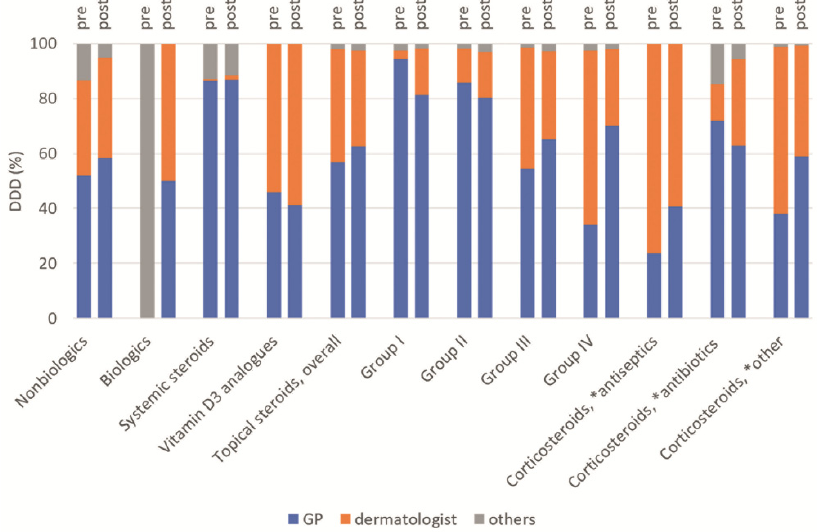
Figure 2. Proportion of defined daily dose (DDD) of the most prescribed psoriasis-relevant drugs by prescribing specialist group in pre–post comparison (N = 718 patients). GP, general practitioner; * in combination with.